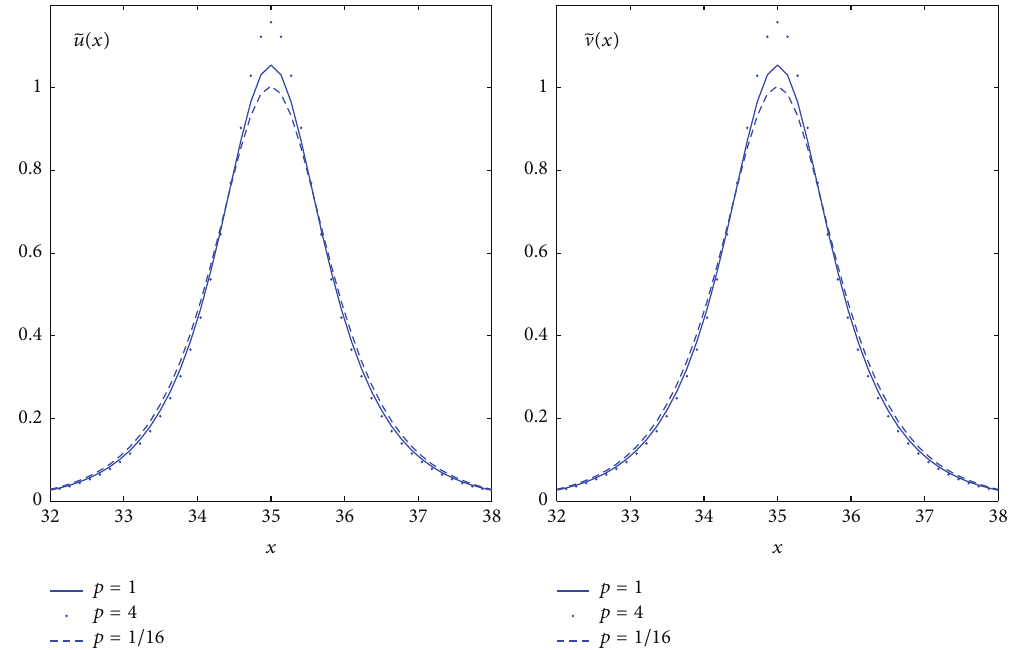
Figure 7: Effect of the model’s coefficients 𝑎 , 𝑏 , 𝑐 , 𝑑 on the shape of the soliton solutions. Here 𝑒 ≡ 0 , 𝛿 = 1 , 𝛼 1 = 𝛼 2 = 1.5 , 𝜎 1 = 𝜎 2 = 0 , = 35 , and 𝑎(𝑥) = 𝑏(𝑥) = 𝑐(𝑥) = 𝑑(𝑥) = sech 𝑝 (𝑥 − 𝑥 𝐾 = 0.5 , 𝑥 0